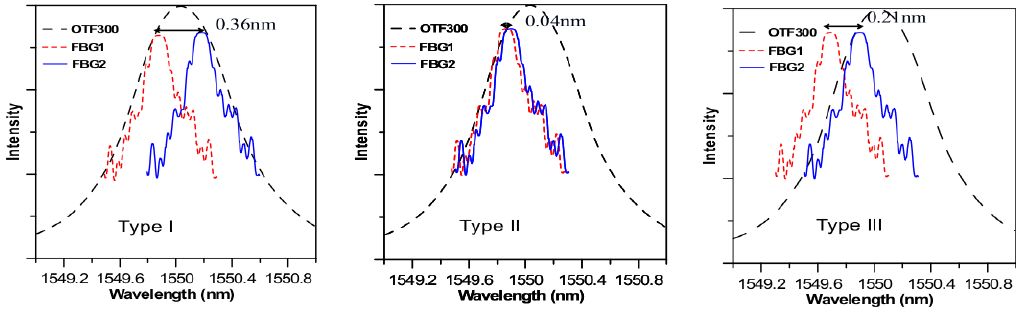
Figure 3. Layout of the spectra of the two Fiber Bragg grating (FBGs) in respect to the edge filter spectrum of OTF300: ( a ) Type I Rosette; ( b ) Type II Rosette; ( c ) Type III Rosette.